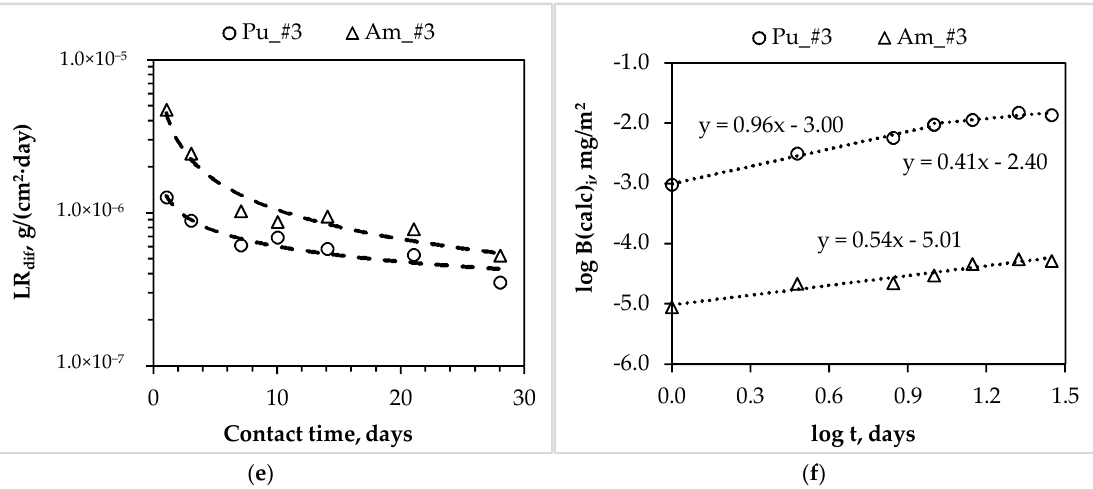
Figure 3. Dependence of the differential leaching rate (LR dif ) of actinides and rare earth elements (REE) ( a , c , e ) and the logarithmic dependence of their yield (log B (calc) i ) from compounds ( b , d , f ) on contact time with water (indices #1, 2, 3 correspond to compounds containing actinides and REE). Table 3. The leaching mechanism of components of the MKP compounds (indices #1, 2, 3 correspond to the names of compounds containing actinides and REE).